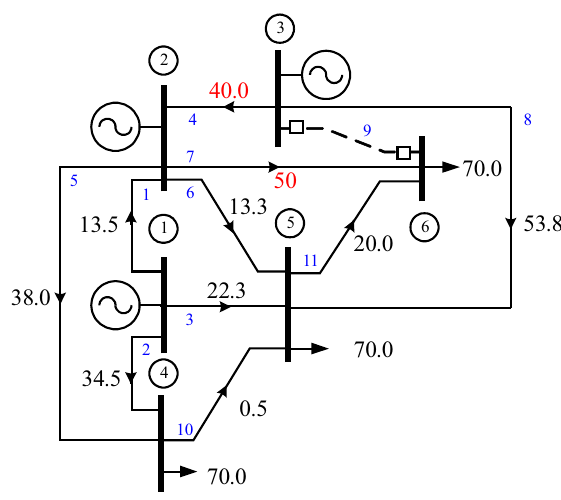
Figure 2. Power flow solution considers the outage of line 3–6.